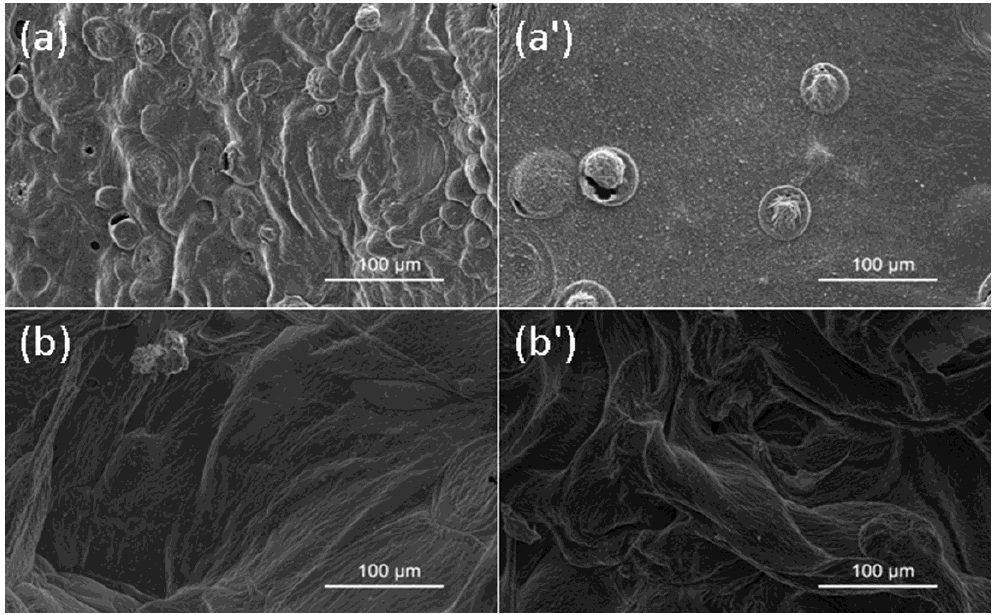
Figure 9. The Inner surface (left row) and Inner layer (right row) for PA6/ABPA/CMMT ( a , a’ ) and PA6/ABPA/PMMT ( b , b’ ).